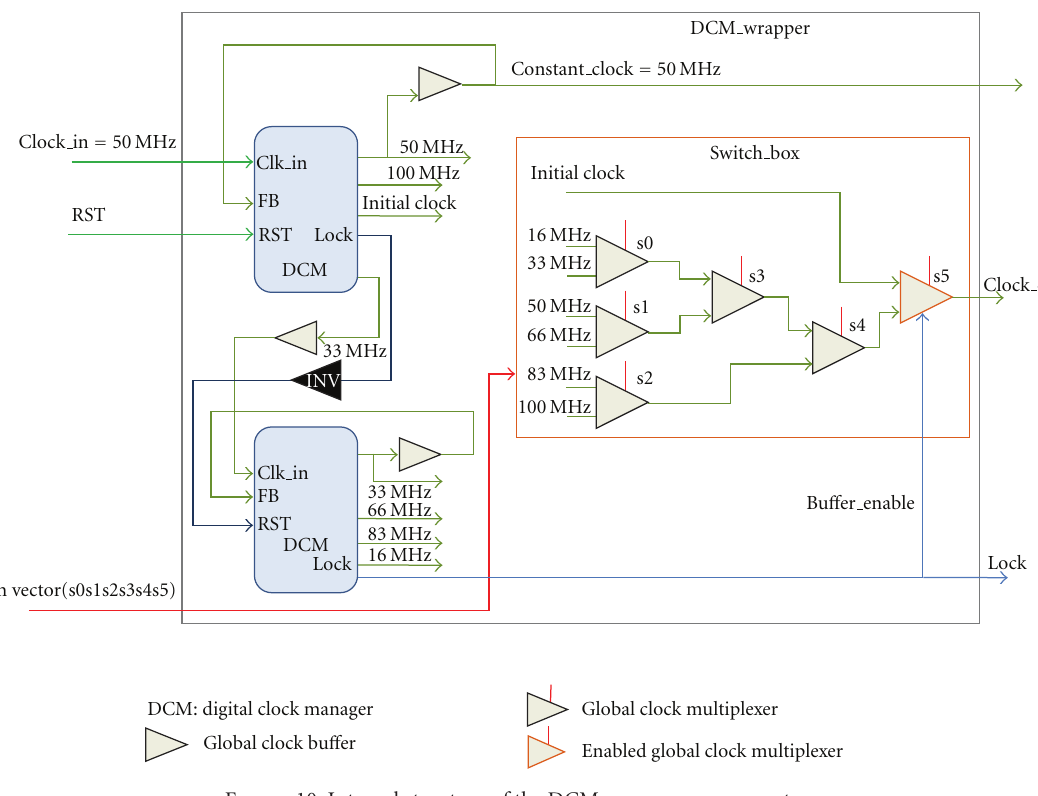
Figure 10: Internal structure of the DCM wrapper